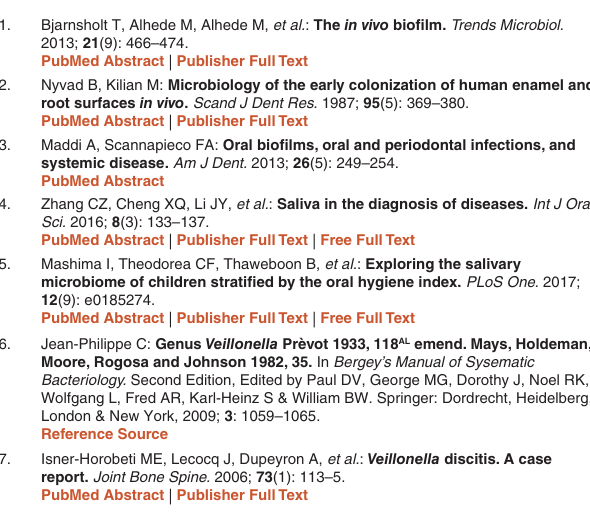
Figshare: Raw Data Saliva Japanese Children.xlsx. https://doi.org/ 10.6084/m9.figshare.7856657.v1 26